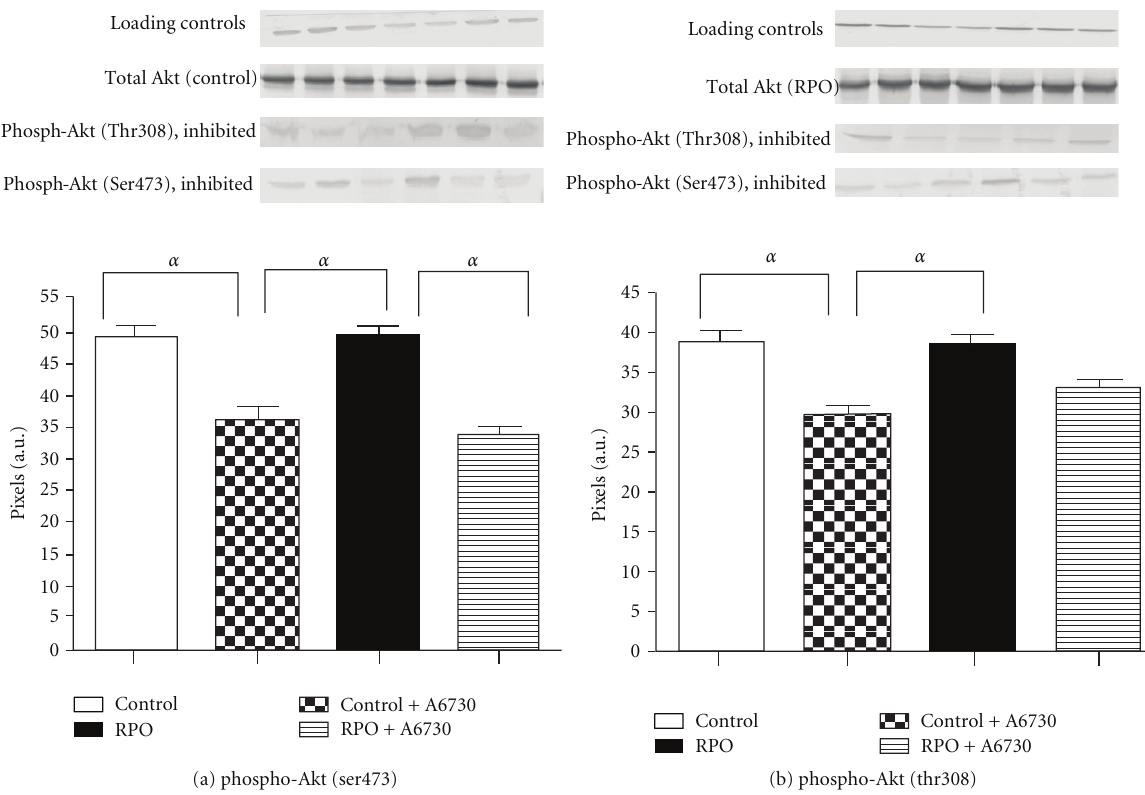
Figure 6: The e ff ect of RPO and A6730 on Akt phosphorylation (Ser473 (a) and Thr308 (b) residues). Results are expressed as means ± SEM, n = 6-7/group ( α P < 0 . 01 for indicated